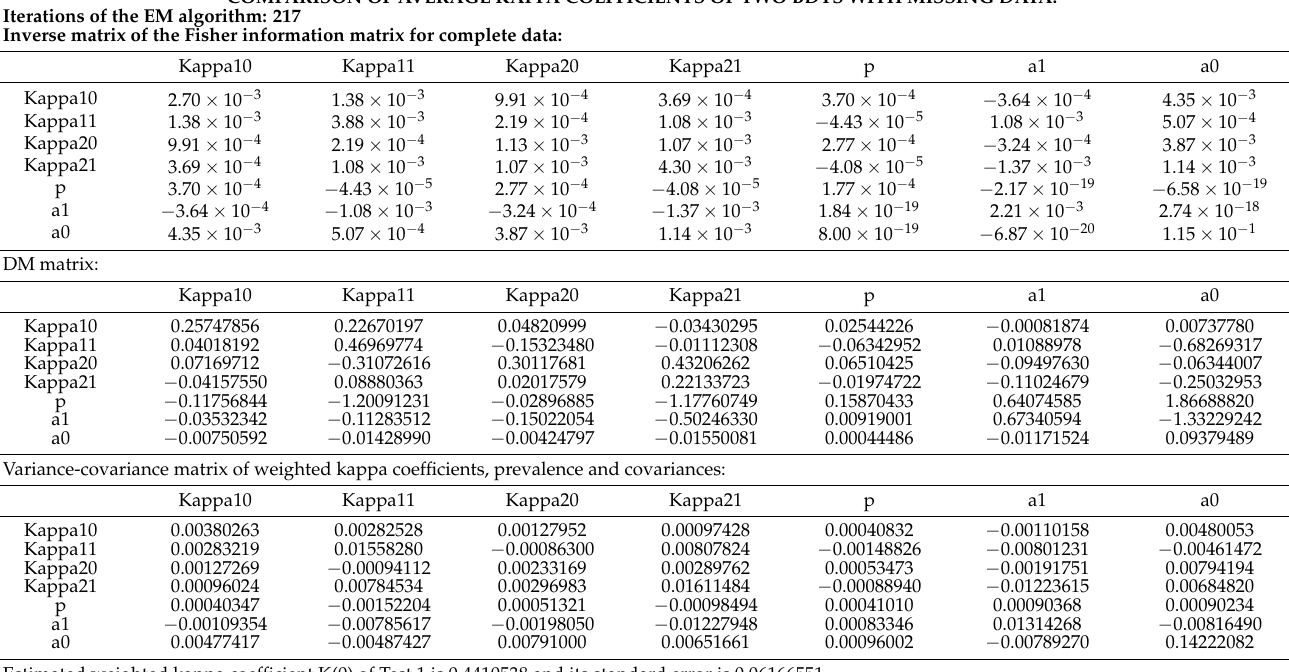
Table 8. Results for the example of the diagnosis of Alzheimer’s disease. COMPARISON OF AVERAGE KAPPA COEFFICIENTS OF TWO BDTS WITH MISSING DATA: Iterations of the EM algorithm: